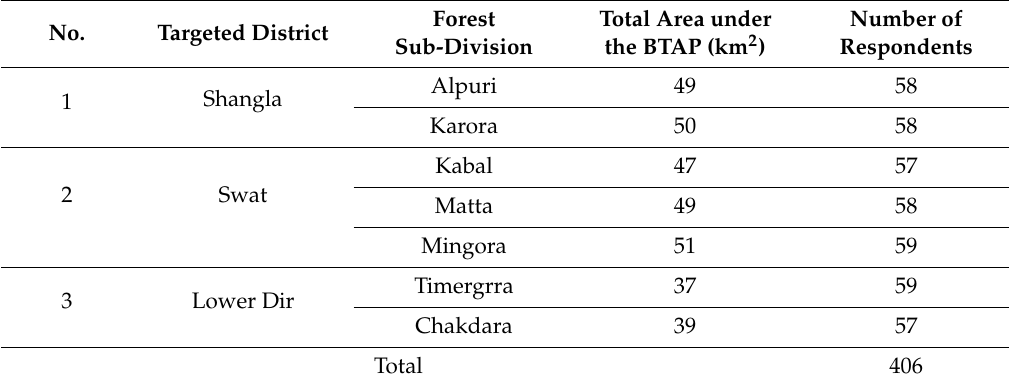
Table 2. Number of respondents in the sample